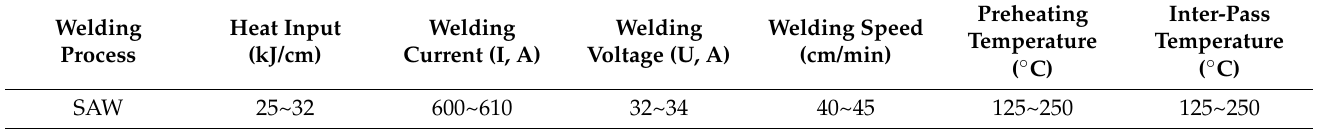
Table 4. Welding